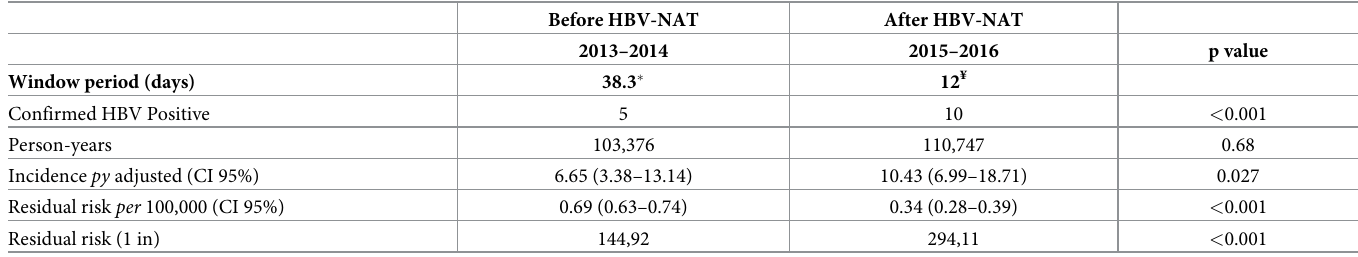
Table 4. Py incidence rates and residual risks for HBV before (2013–2014) and after (2015–2016) HBV-NAT